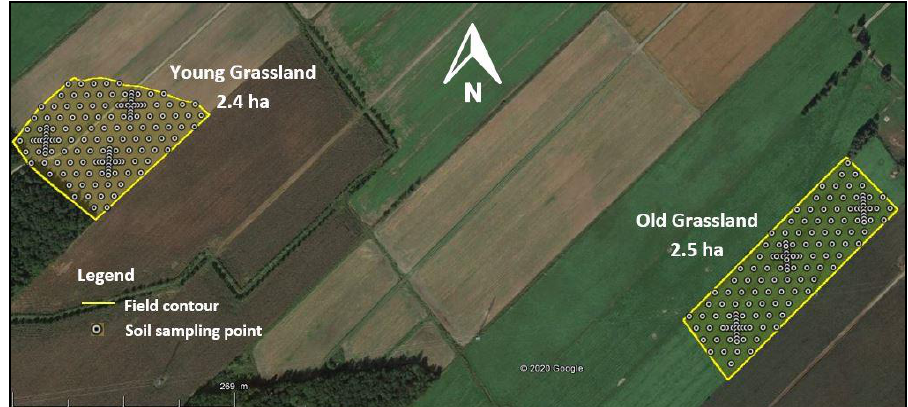
Figure 1. Location and sampling strategies design of the studied grassland sites (Google Maps. Accessed 15 June 2020).